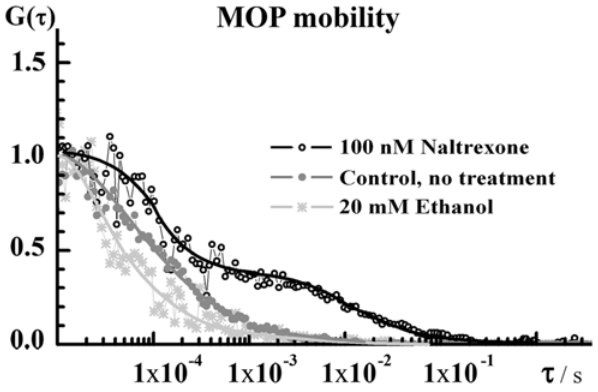
Figure 2. Normalized temporal autocorrelation curves showing the effect of ethanol and naltrexone on MOP-EGFP lateral mobility in the plasma membrane. The shift of the autocorrelation curve to shorter correlation times (stars) indicates that ethanol somewhat impels the lateral mobility of MOP-EGFP. In contrast, naltrexone markedly slowed down the lateral mobility of MOP-EGFP. The temporal autocorrelation curve (open circles) assumed a complex shape, indicating the formation of a slowly moving component.